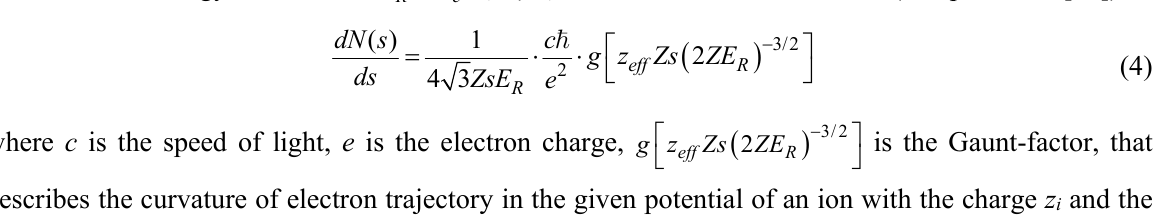
Figure 1. Effective charge in Thomas-Fermi model, calculated from Equation (3) versus reduced frequency for ions W 22+ (solid curve), W 28+ (dashed curve), W 34+ (short dashed curve). The EQP number ( ) / dN s ds with the reduced frequency s per unit frequency interval ds for